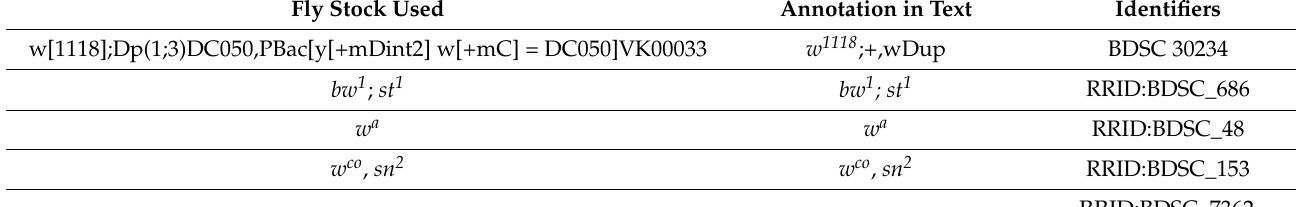
Table 1. Sources of Drosophila